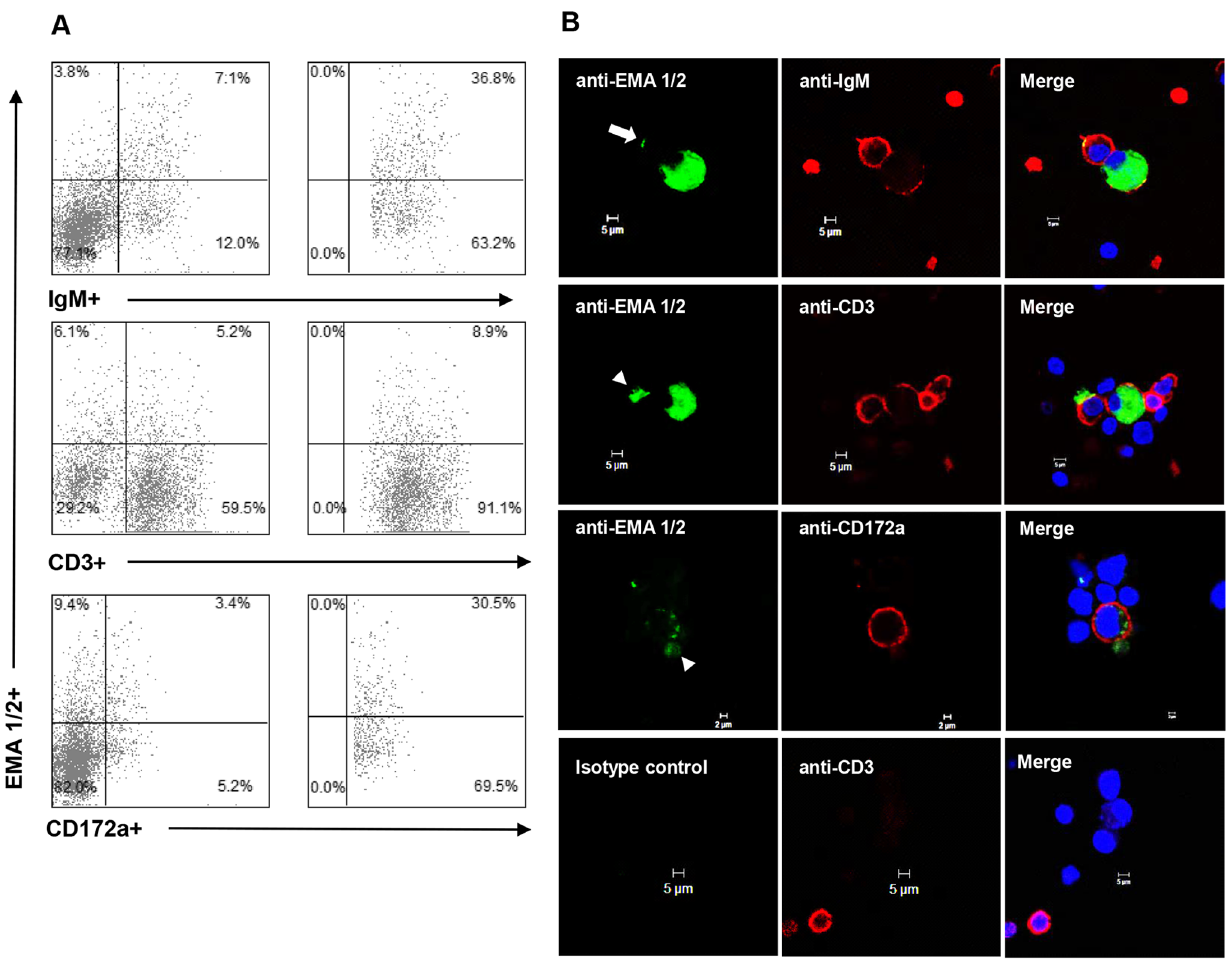
Figure 3. Immunophenotype of schizont-infected PBMC invitro . Flow cytometric (A) and IFA (B) analysis of schizont-infected cells in vitro . (A) Representative flow cytometric data for infect horse H2. Left column: percent of total PBMC dual labeled with leukocyte specific mAbs and T. equi specific mAb (anti-EMA 1/2). Right column: percent infected cells determined on IgM + (B lymphocyte), CD3 + (T lymphocyte), or CD172a + (macrophage) gated leukocytes. (B) IFA images of schizont-infected cells dual-labeled with one of the three leukocyte specific mAb and anti-EMA 1/2. The nuclei of all cells were stained blue with DAPI. The anti-EMA 1/2 mAb either formed diffuse signal throughout the cytoplasm of infected cells or discrete signal along the surface of intracytoplasmic macroschizonts. Rare cells had punctate foci of EMA 1/2 + immunoreactivity along their outer margin (top left panel; arrow). The space adjacent to cells multifocally contained scant, irregular to round, immunoreactive debris (left panels of second and third row; arrowhead). The anti-IgM, anti-CD3, and anti-CD172a mAb formed punctate to diffuse signal along the outer surface of infected cells. Labeling with an isotype control for the anti-EMA 1/2 mAb did not form any detectable signal (representative data shown in the bottom panels of